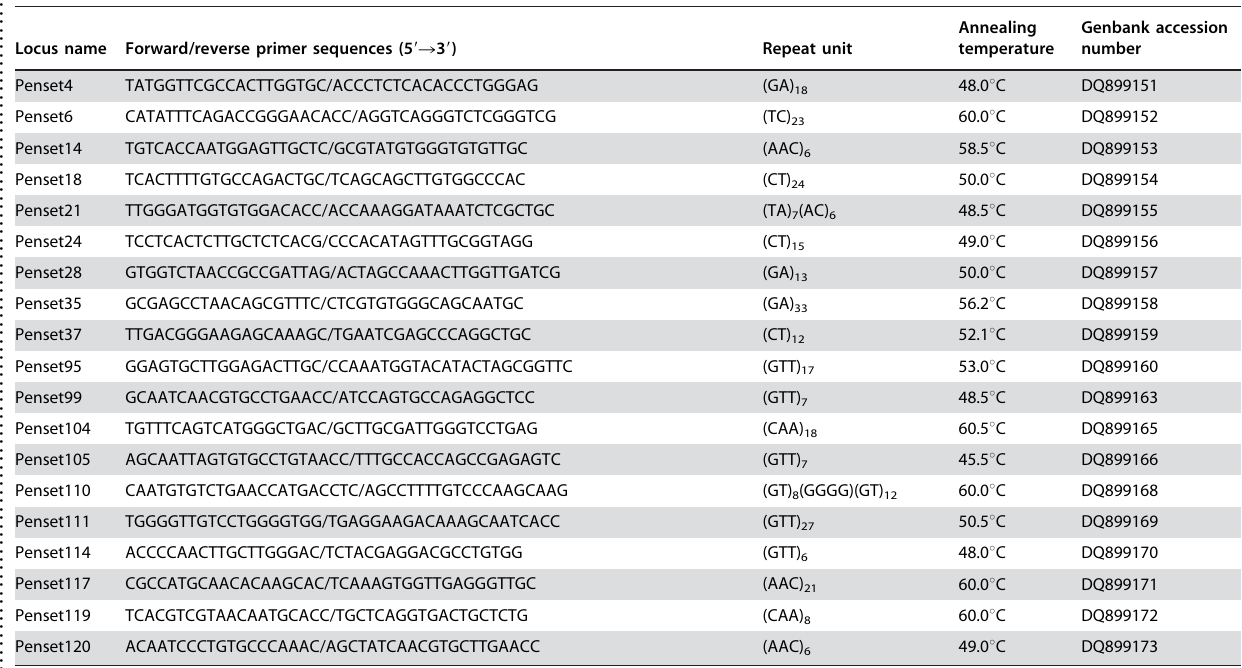
Table 1. Characteristics of the 19 microsatellite markers developed and used in this study. .. ... .... ... ... .... ... ... .... ... ... .... ... ... .... ... ... .... ... ... .... ... ... .... ... ... .... ... ... .... ... ... .... ... ... .... ... ... .... ... ... .... ... ...